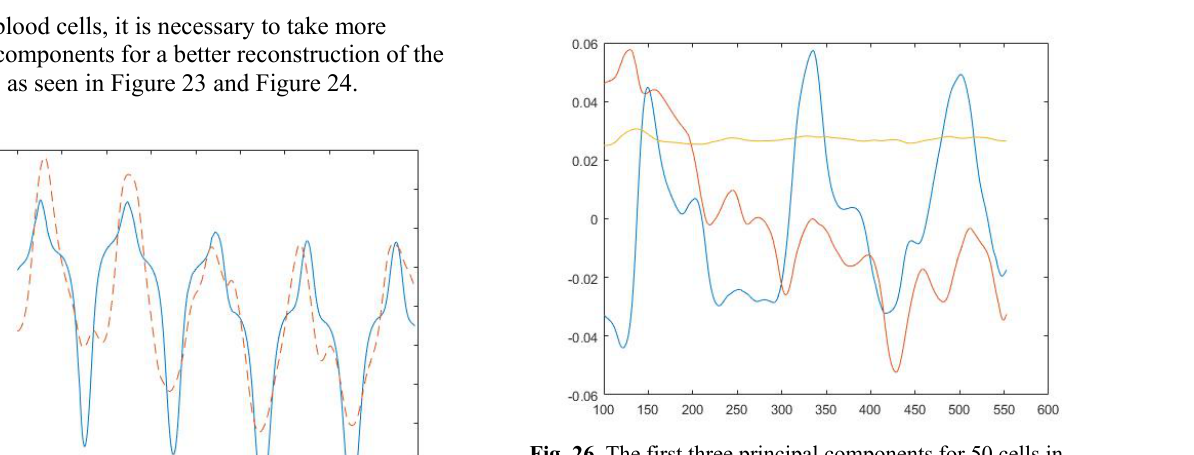
Fig. 26. The first three principal components for 50 cells in geometry A., seeding a.